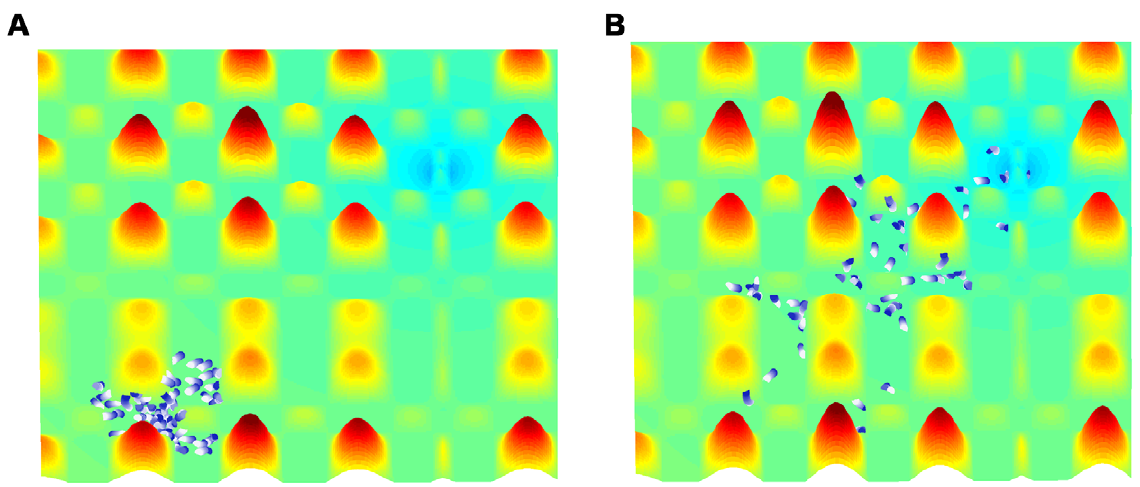
Figure 4. Frames from the simulation show independent agents moving towards the target. A. Simulation step 100. B. Simulation step (cid:6) RO RA 2000. N ~ 50, RR , , RR RR